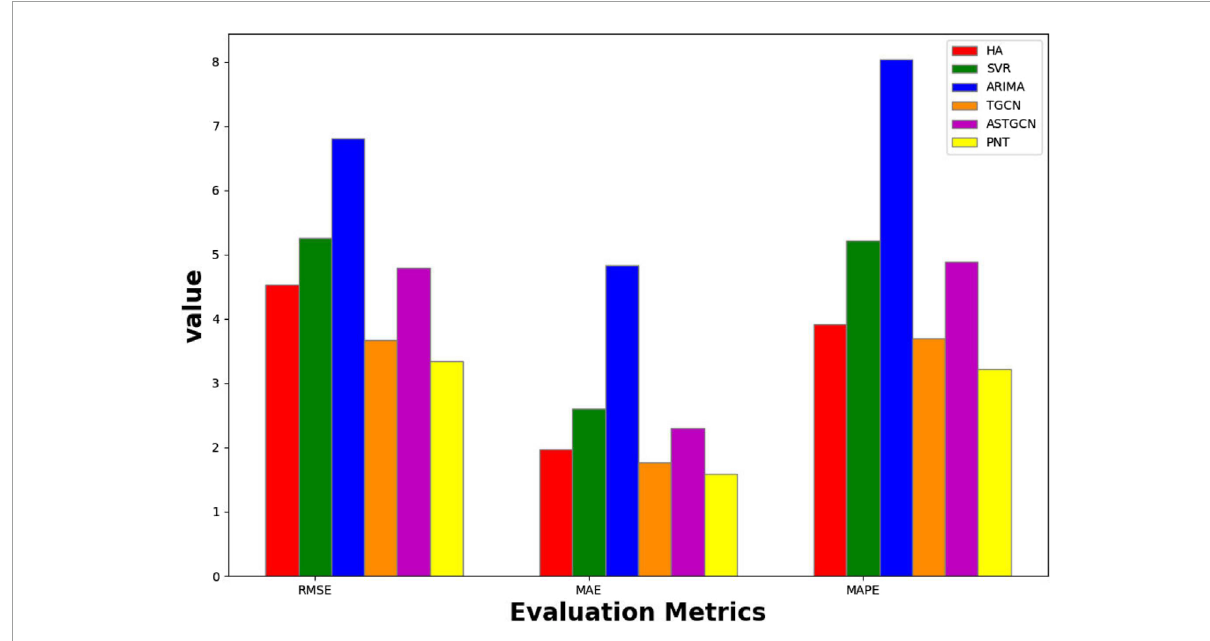
FIGURE 9 pems04-30